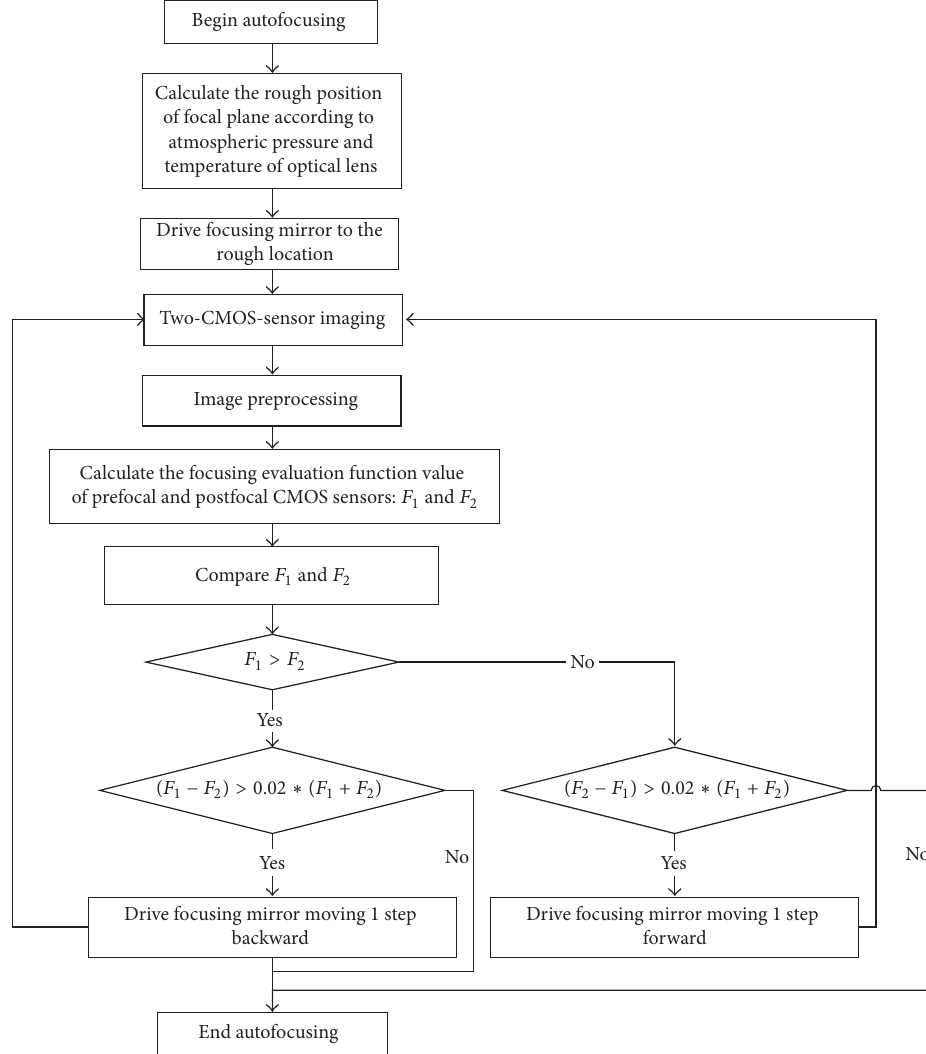
Figure 5: Soft flow diagram for